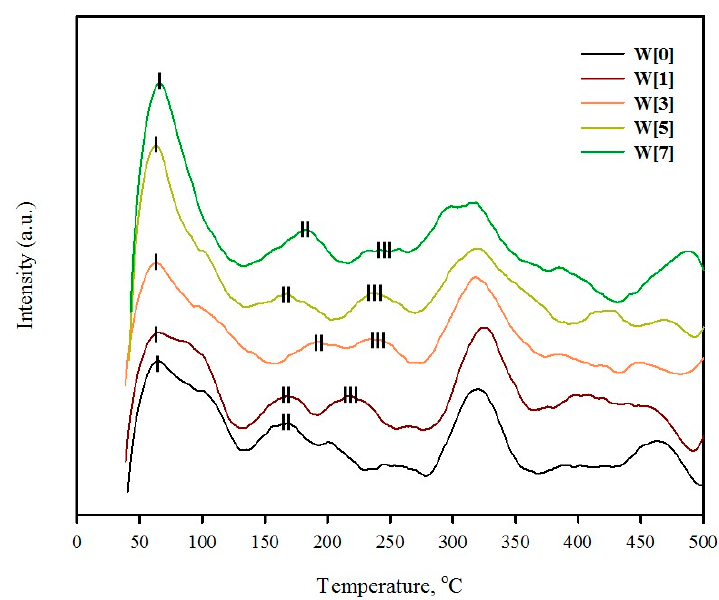
Figure 4. H 2 -TPR profiles of Pt–W[x] / TiO 2 catalysts.